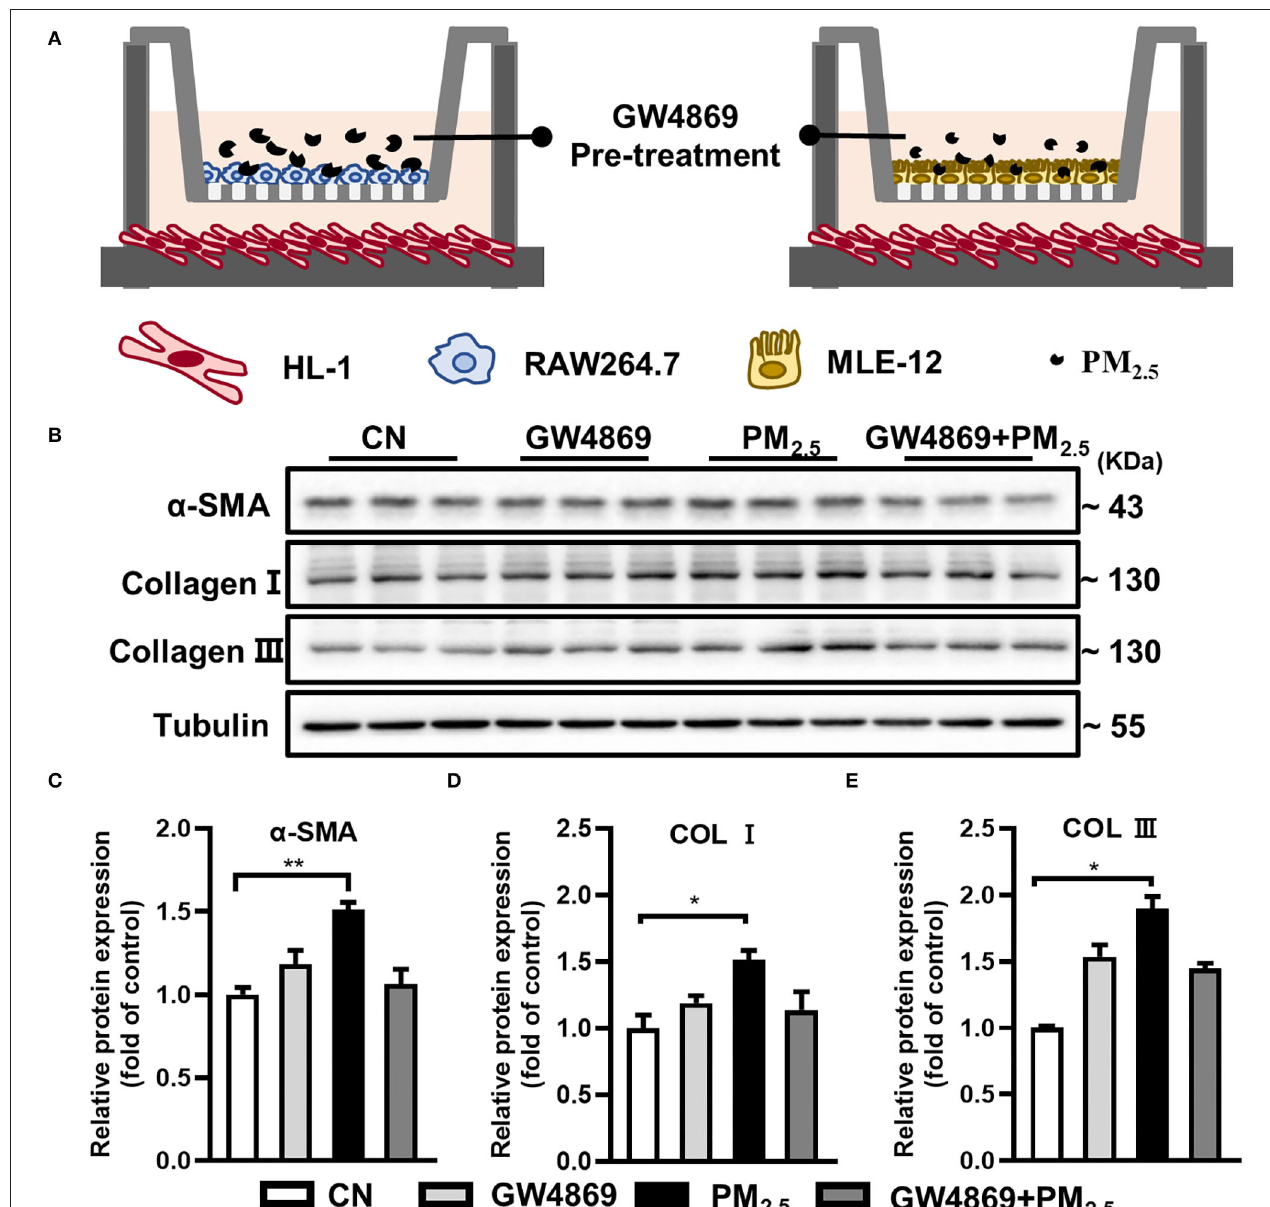
FIGURE 3 | PM 2.5 -treated macrophage-sEV increased collagen expressions in cardiomyocytes. (A) HL-1 cells cocultured with RAW264.7 and MLE-12 in the presence or absence of PM 2.5 and GW4869 in a transwell (0.4 µ m) plate. (B–E) Cocultured with RAW264.7 and PM 2.5 promoted the protein levels of α -SMA, Col I, and Col III in HL-1 cells through transwell system. All the data were presented as mean ± SEM ( t -test, one-way ANOVA), *indicates p < 0.05, **indicates p < 0.01.